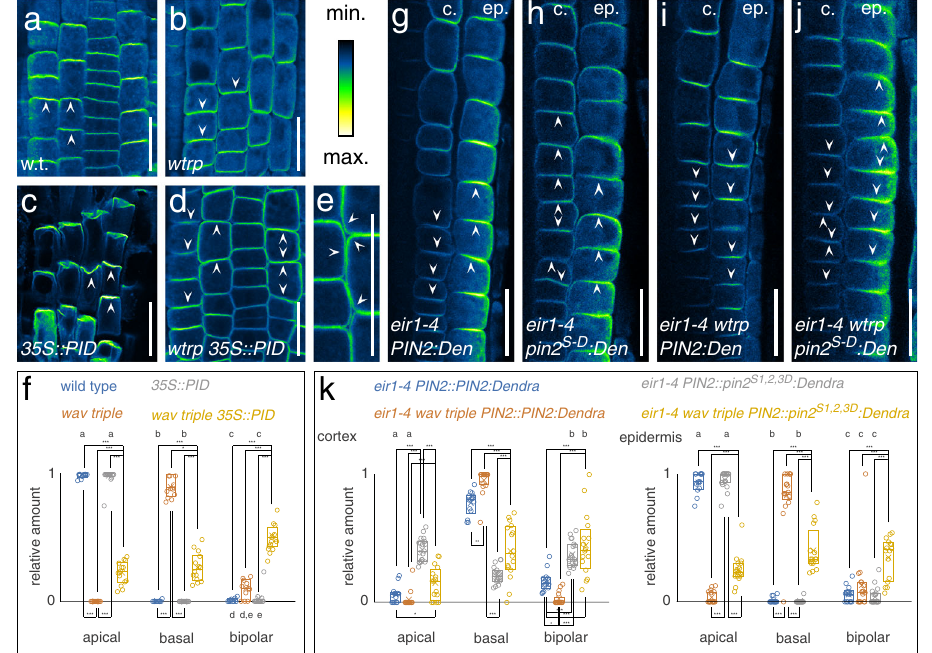
Fig. 5 | Interplay of PINOID/WAG activity and WAV3/WAVH genes in PIN2 polarity control. PIN2 localization in 4 DAG wild type (w.t.; a , f ; 359 cells/9 roots), wav triple ( wtrp ; b , f ; 265 cells/11 roots), 35S::PID ( c , f ; 317 cells/15 roots) and wav triple 35S::PID ( d – f ; 429 cells/14 roots) root meristem epidermis cells. Arrowheads indicated polarity of PIN2 localization. g – k PIN2 localization in cortex ( ‘ c. ’ ) and epidermis ( ‘ ep. ’ ) root meristem cells of eir1-4 PIN2::PIN2:Dendra ( eir1-4 PIN2:Den ; g , k ; 243 cortex cells/212 epidermis cells/14 roots), eir1-4 PIN2::pin2 S1,2,3D :Dendra ( eir1-4 pin2 S-D :Den ; h , k ; 326 cortex cells/372 epidermis